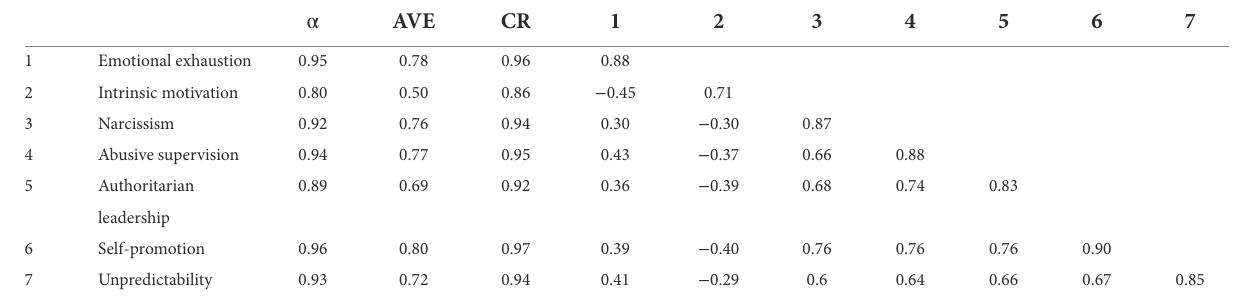
TABLE 1 Reliability and